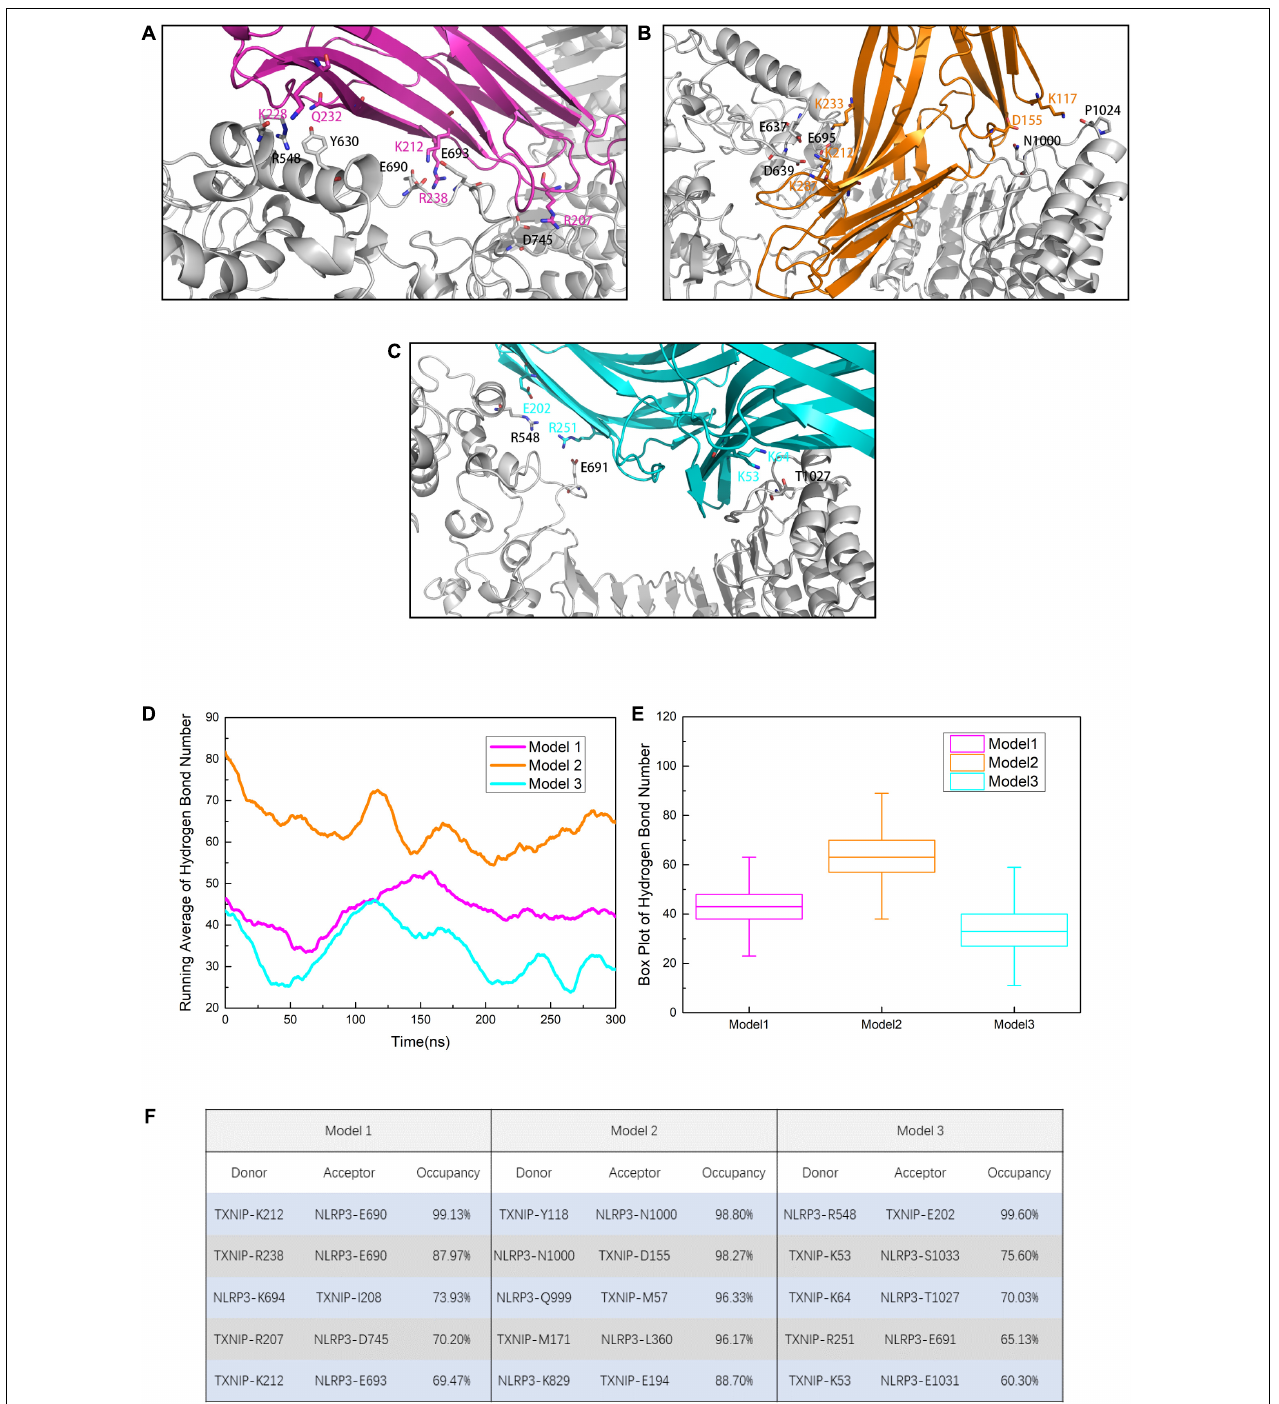
FIGURE 4 | Residues involved in the intermolecular polar contacts of the NLRP3/TXNIP complexes in (A) Model 1, (B) Model 2, and (C) Model 3. The residues of NLRP3 are indicated in black, while the residues of TXNIP are indicated in magenta/orange/cyan. (D) Running average hydrogen bond number statistics of Models 1, 2, and 3 after the 300 ns simulation (each point is the average of nearby 100 frames). (E) The box plot of hydrogen bond number. Whiskers showed the outlier number with a coefficient of 1.5 and the boxes ranged from 25% to 75%. (F) The top five hydrogen bond occupancy, donors, and acceptors of Models 1, 2, and 3.